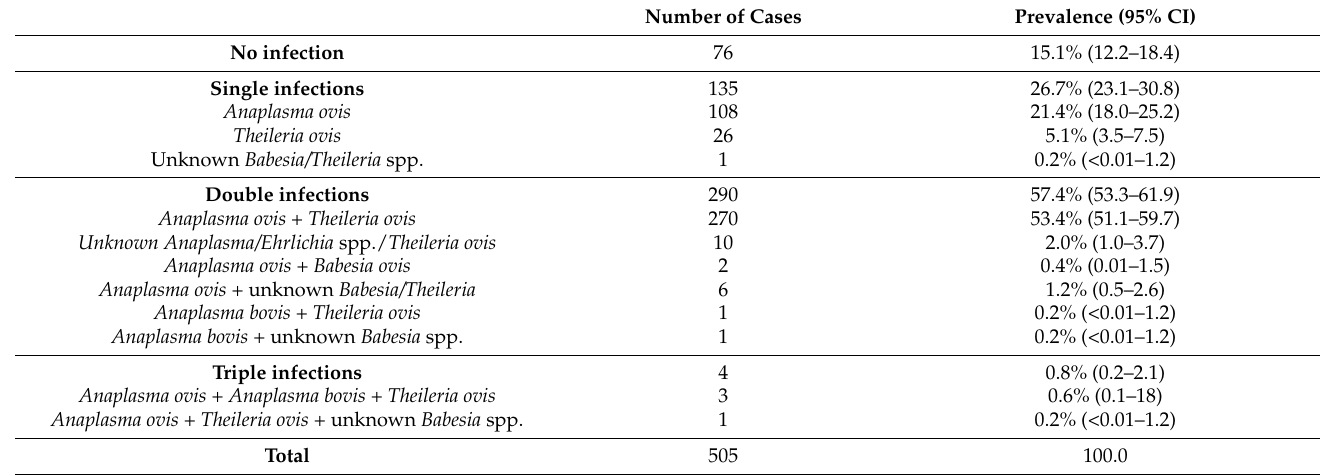
Table 3. Prevalence of single and mixed infections (including 95% CIs) detected in sheep during the study period (abbreviations: CI, confidence